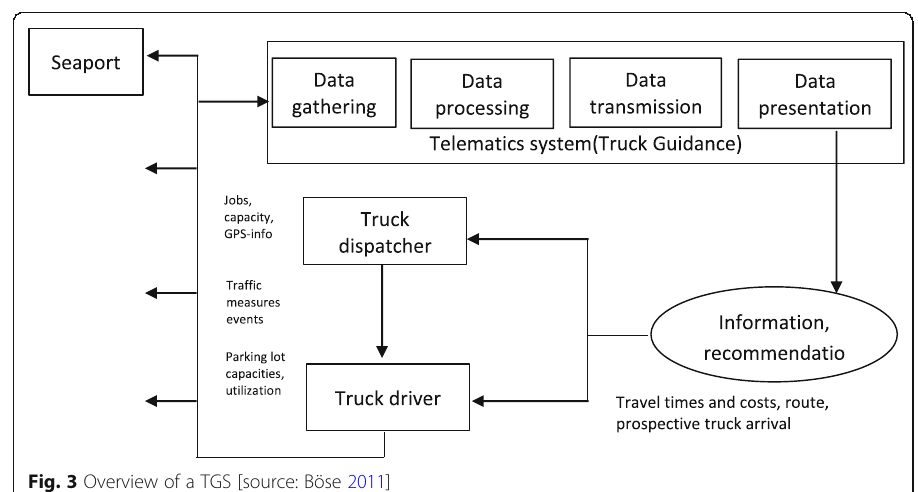
Fig. 3 Overview of a TGS [source: Böse